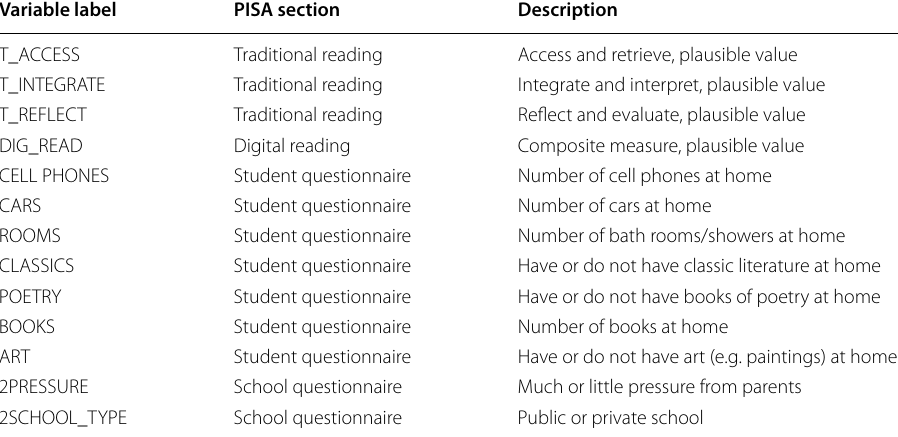
Table 2 The variables from the PISA 2009 databases, PISA section they are taken from, and descriptions of tasks/questions